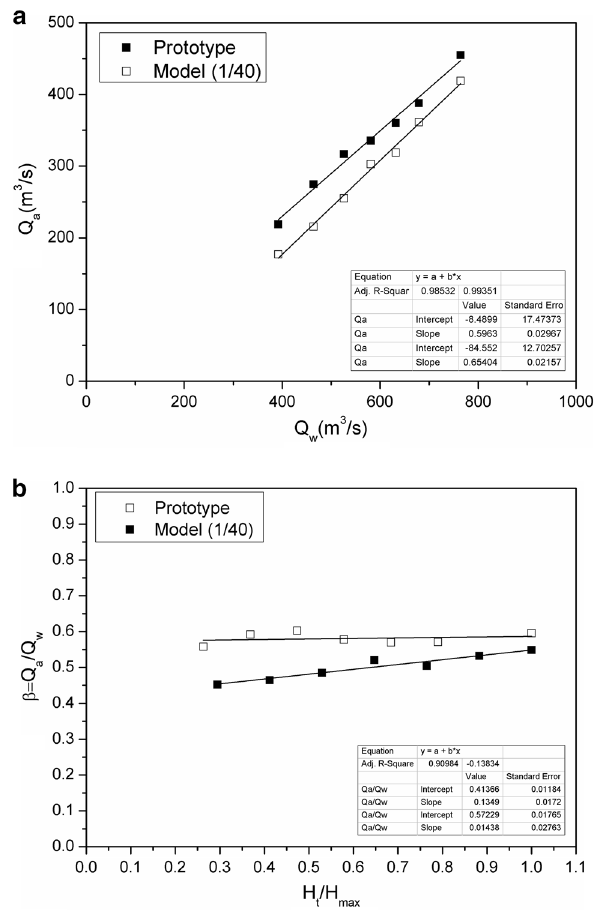
Fig. 6 Model–prototype comparison for CFD results: a air entrain- ment discharge, b air entrainment